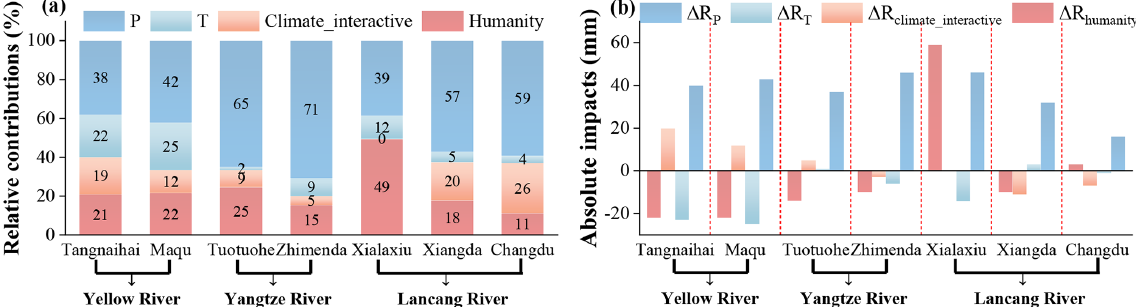
Figure 7. Relative contributions (a) and absolute impacts (b) of the different influencing factors on the annual runoff trends at the seven stations. The numbers in (a) represent the relative contributions of the influencing factors as percentages.